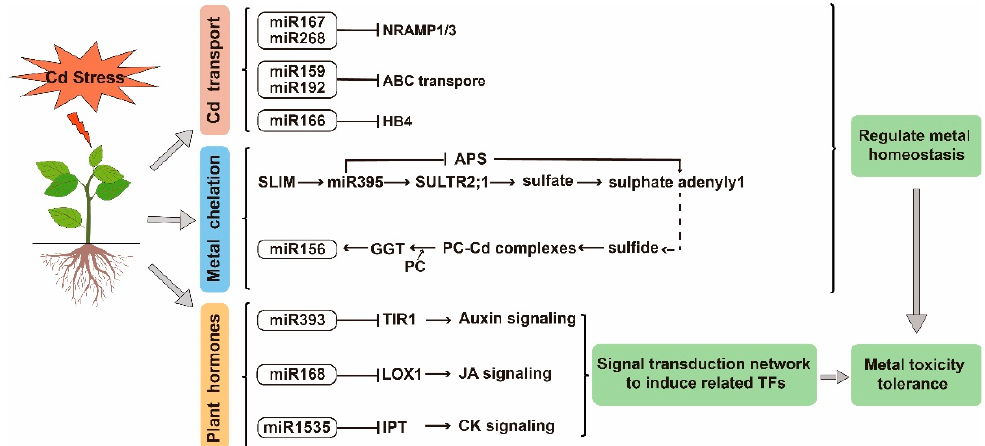
Figure 3. The regulatory network of miRNA target genes is involved in the response of plants to Cd stress. The blue area indicates the pathway by which miRNA participates in metal chelation. The green region represents the process by which miRNA participates in metal transport. The orange area indicates that miRNA participates in the regulation of related plant hormone signaling pathways, including auxin, jasmonic acid, and cytokinin.